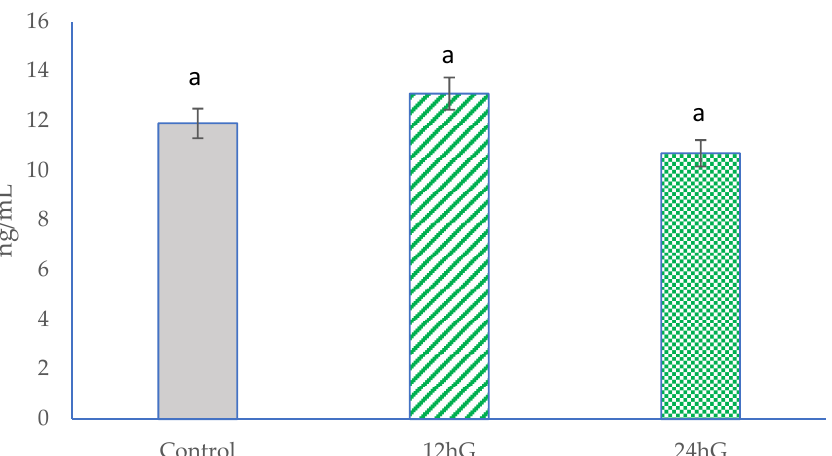
Figure 1. Milk cortisol levels at the beginning of the experiment in dairy cows. Control: non-grazing group; 12 hG: 12 h grazing group; 24 hG: 24 h grazing group. Columns represented by the same letters are not significantly different at p > 0.05.